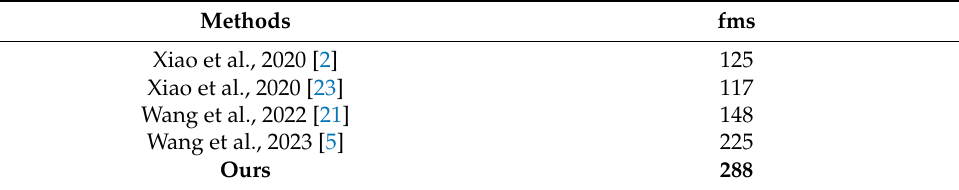
Table 6. Comparison of different methods in terms of time costs.